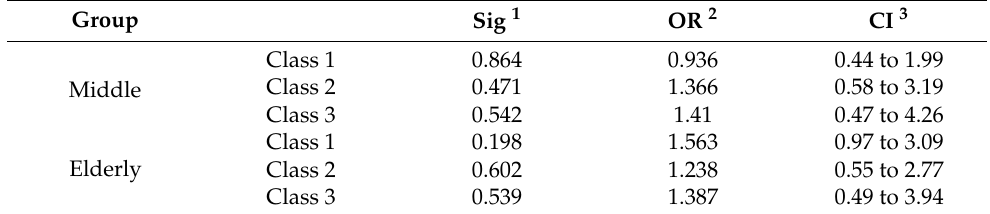
Table 3. Multivariate logistic regression results of qualitative analysis of the crack class.